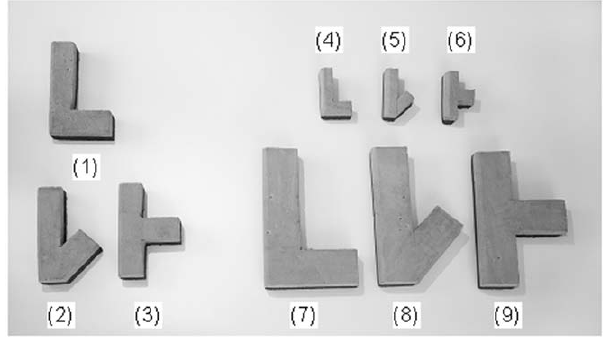
Figure 3. Objects used in experiment 3. Gable learnt to link the word gnark with standard object 1: the GNARK object (16 cm * 6 cm). He was asked to select a GNARK from pairs of objects including the GNARK, shape changes 2 and 3, and size changes 4–6 (8 cm * 3 cm) and 7–9 (24 cm * 9 cm).